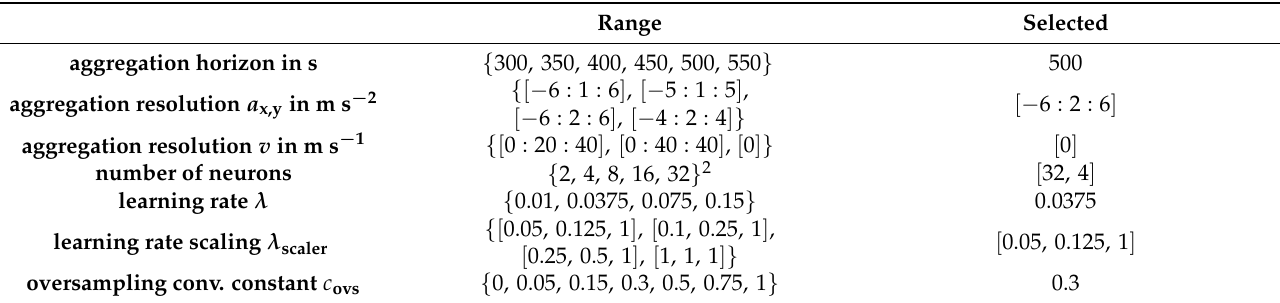
Table 3. Optimal hyperparameter random grid